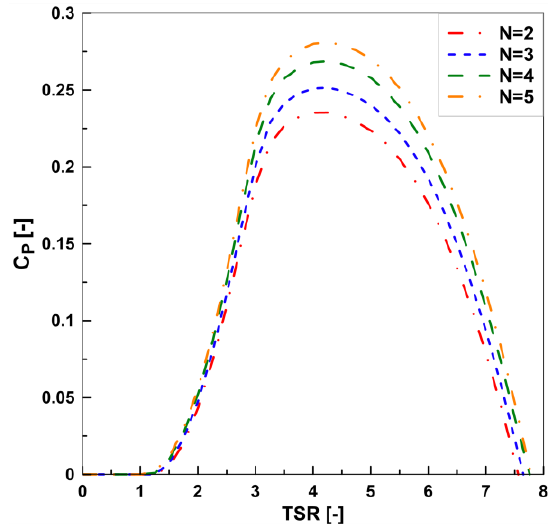
Figure 12. Effect of the number of blades on the turbine efficiency Figure 12. E ff ect of the number of blades on the turbine e ffi ciency.